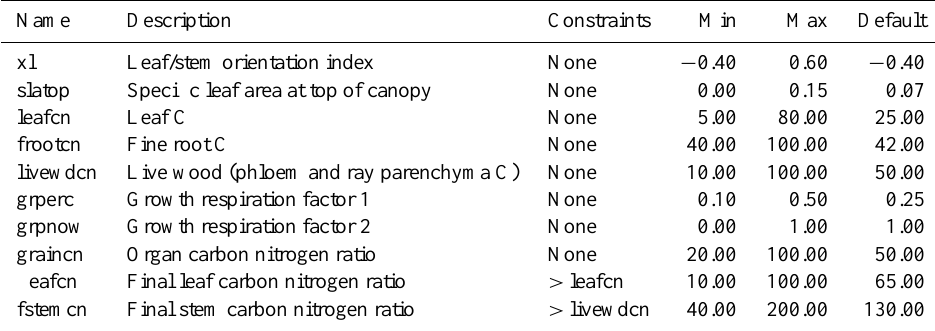
Table 1. Prior information on the parameters.